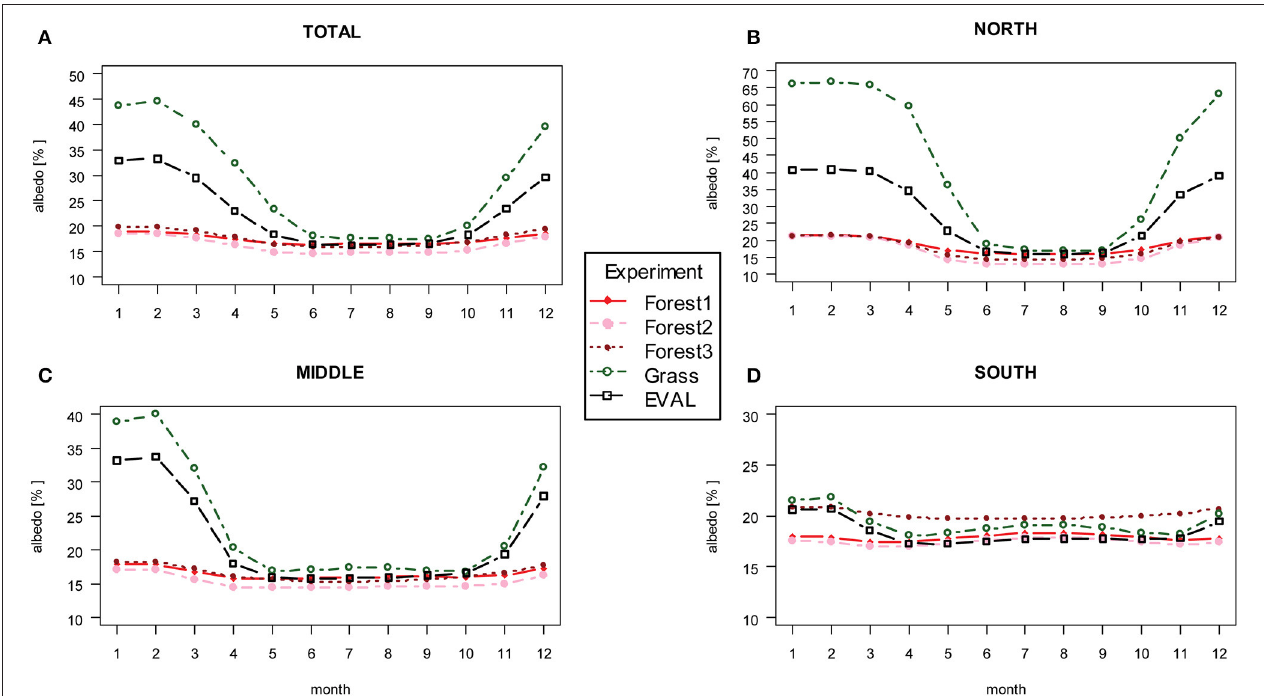
FIGURE 3 | Domain averaged long-term mean seasonal cycle of the albedo of FOREST1 (red), FOREST2 (rose), FOREST3 (dark red), GRASS (dark green), and EVALUATION (black) over all land points only for 1986–2015. Albedo values are displayed for the whole of the domain TOTAL (A) , and with latitudinal separation in NORTH (B) for high-latitudes (note the different y-axis scale), MIDDLE (C) for mid-latitudes, SOUTH (D) for the Mediterranean (note the different y-axis